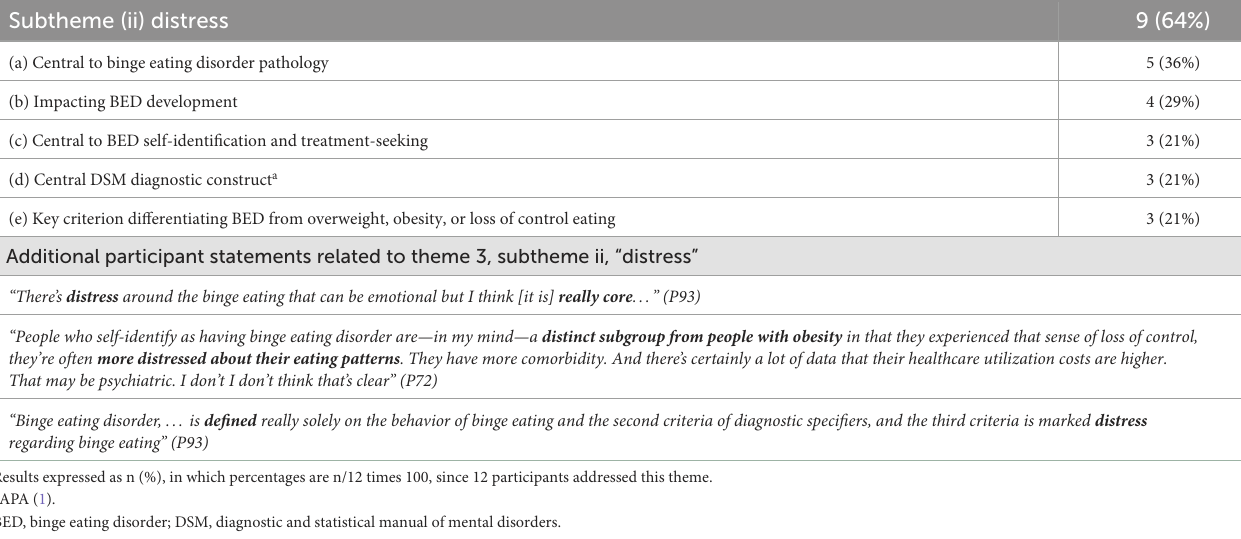
TABLE 9 Participant responses consistent with theme 3, subtheme ii,